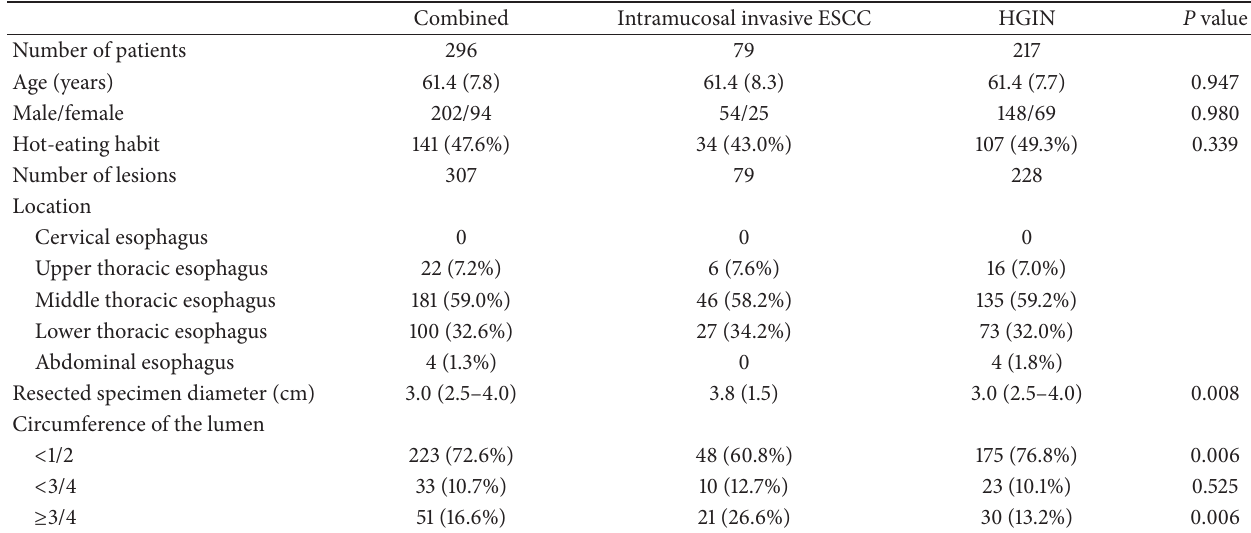
Table 1: Patient and lesion characteristics.